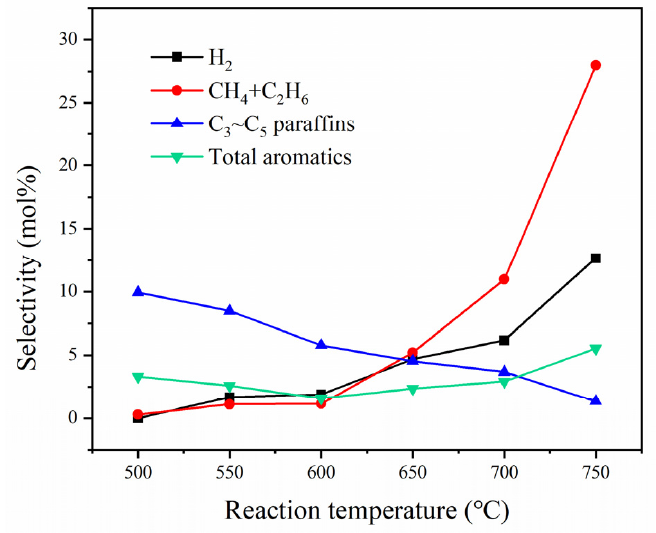
Figure 3. Selectivities of byproducts from pentene cracking over H-ZSM-5 vs. reaction temperatures. Reaction conditions: total pressure, 130 kPa; partial pressure, 60 kPa; WHSV, 83 h − 1 .